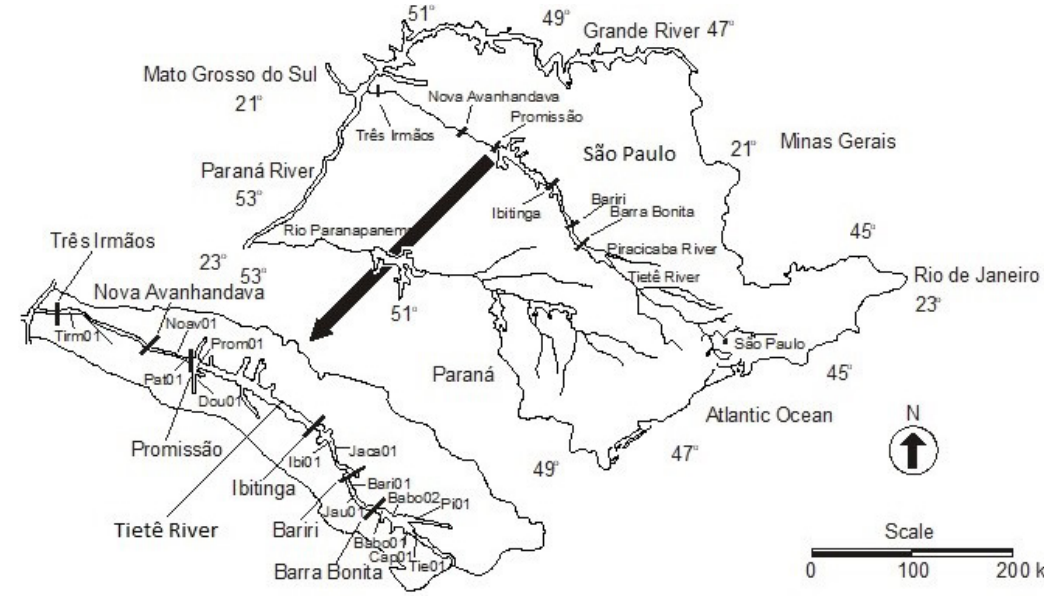
Figure 1. Location of the reservoirs, main tributaries and distribution of the sampling stations in the Tietê River,